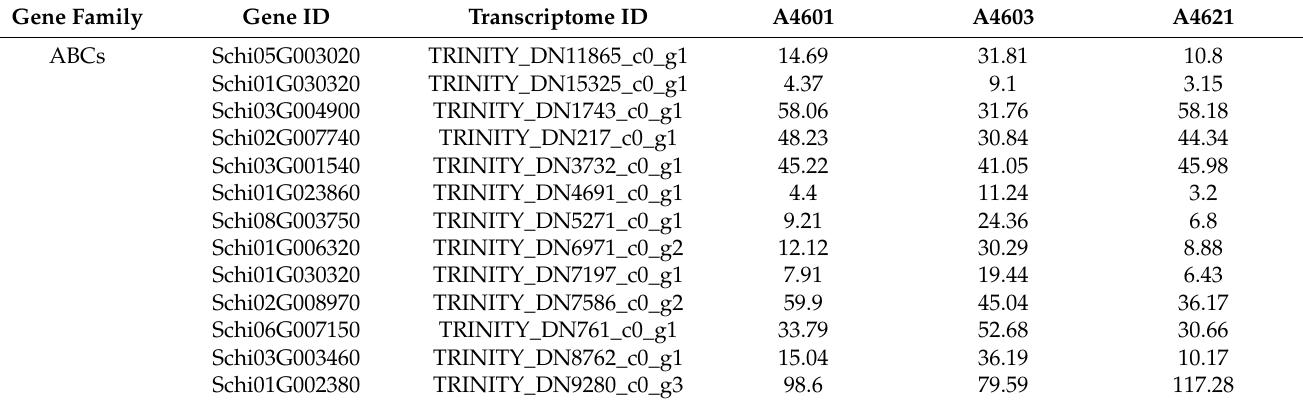
Table 2. Nucleotide substitution rate of detoxification genes in S. chinensis.